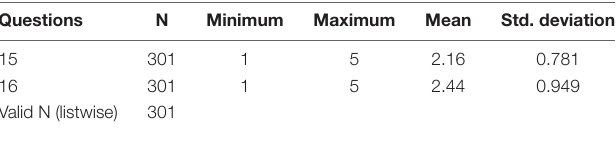
TABLE 13 | Descriptive statistics of the questions related to the learners’ technophobia in technology-integrated classrooms. Questions